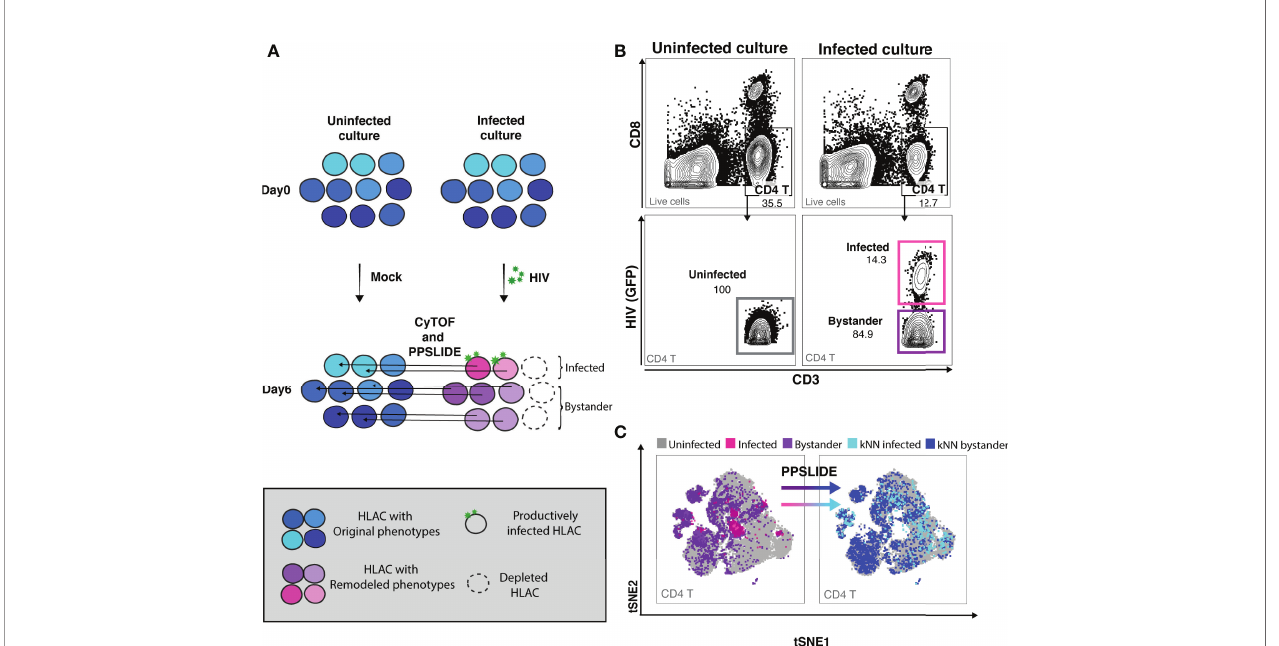
FIGURE 2 | CyTOF and PP-SLIDE analysis of HIV-associated killing in HLAC system. (A) Schematic of CyTOF and PP-SLIDE experimental strategy. HLAC cells were mock-treated or infected with HIV.GFP for 6 days and then processed for CyTOF analysis. Only cells that are productively infected express GFP. For every infected cell (in pink), we employed PP-SLIDE to trace it back to the most phenotypically similar cell in the uninfected culture using a k-nearest neighbor (kNN) approach. This kNN infected cell harbors the predicted phenotype of the infected cell prior to HIV-induced cell remodeling. Similarly, bystander cells in the HIV- exposed culture (purple) were also mapped to their predicted state prior to infection using PP-SLIDE. The key is shown in the grey inset. (B) Example of manual gating strategies to identify the following CD4 T subsets: uninfected (CD3+CD8-, uninfected culture, gray gate), infected (CD3+CD8-HIV+, infected culture, pink gate) and bystander (CD3+CD8-HIV-, infected culture, purple gate). Preceding parent gates are indicated at the lower left corner. Numbers correspond to percentages for each gate. (C) tSNE plots showing infected (pink dots) and bystander (purple dots) CD4 T cells overlayed onto uninfected CD4 T cells (gray dots). Both infected and bystander CD4 T cells were remodeled as suggested by their presence in regions of the tSNE not occupied by uninfected CD4 T cells. Using PP-SLIDE, infected and bystander CD4 T cells were converted to their predicted original states, kNN infected (aqua dots) and kNN bystander (blue dots) respectively. Preceding parent gates are indicated at the lower left